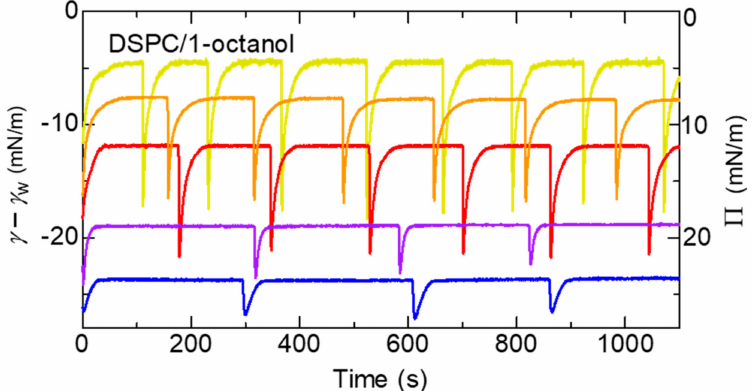
Figure 3. Oscillations of surface tension produced by 1-octanol in the presence of a spread monolayer of DSPC with different initial surface pressure, Π 0 . γ - γ w is the difference of the surface tension with that for water, γ w . Yellow: Π 0 = 5 mN/m; Orange: Π 0 = 7 mN/m; Red: Π 0 = 12 mN/m; Purple: Π Π 0 = 19 mN/m; Blue: 0 = 24